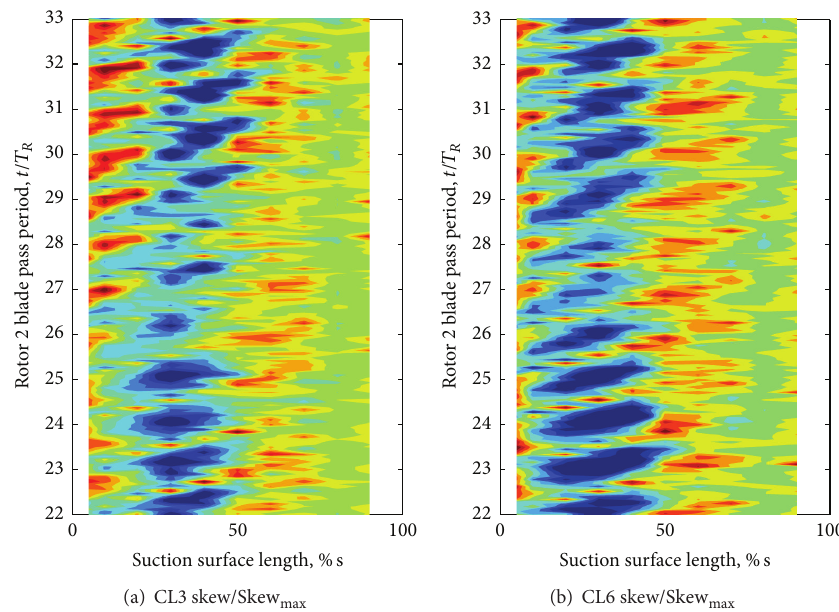
Figure 12: Skew for clocking configurations: (a) CL3 and (b) CL6 at 20% span for 30% SM